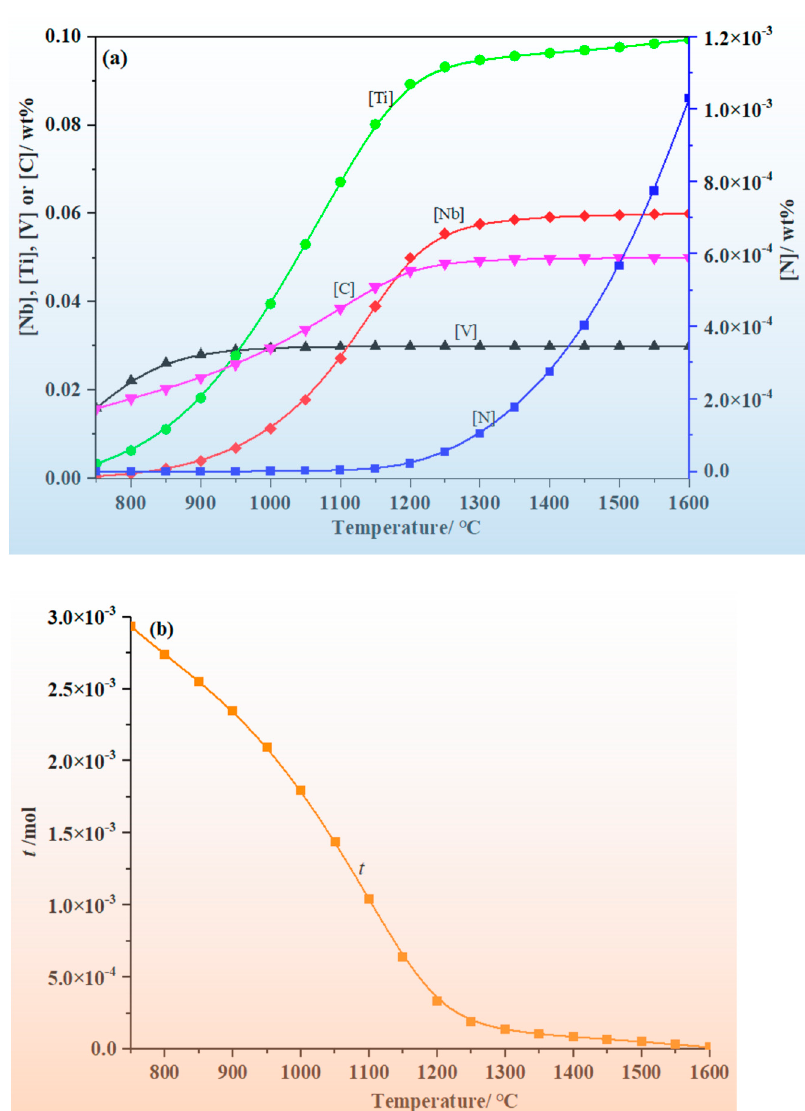
Figure 11. Change in the solid-dissolved contents ( a ) and total molar fraction of secondary phases ( b ) with temperature T obtained from the thermodynamic analysis of N2 steel.